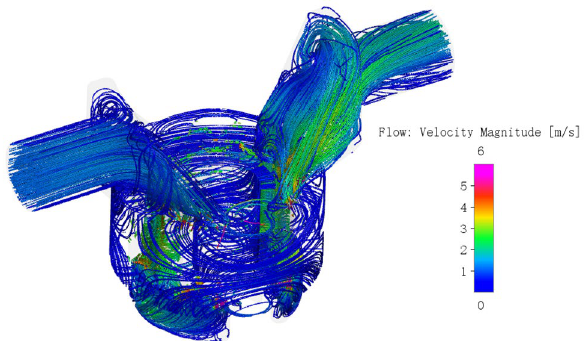
Figure 16. Velocity streamline diagram of the pump.